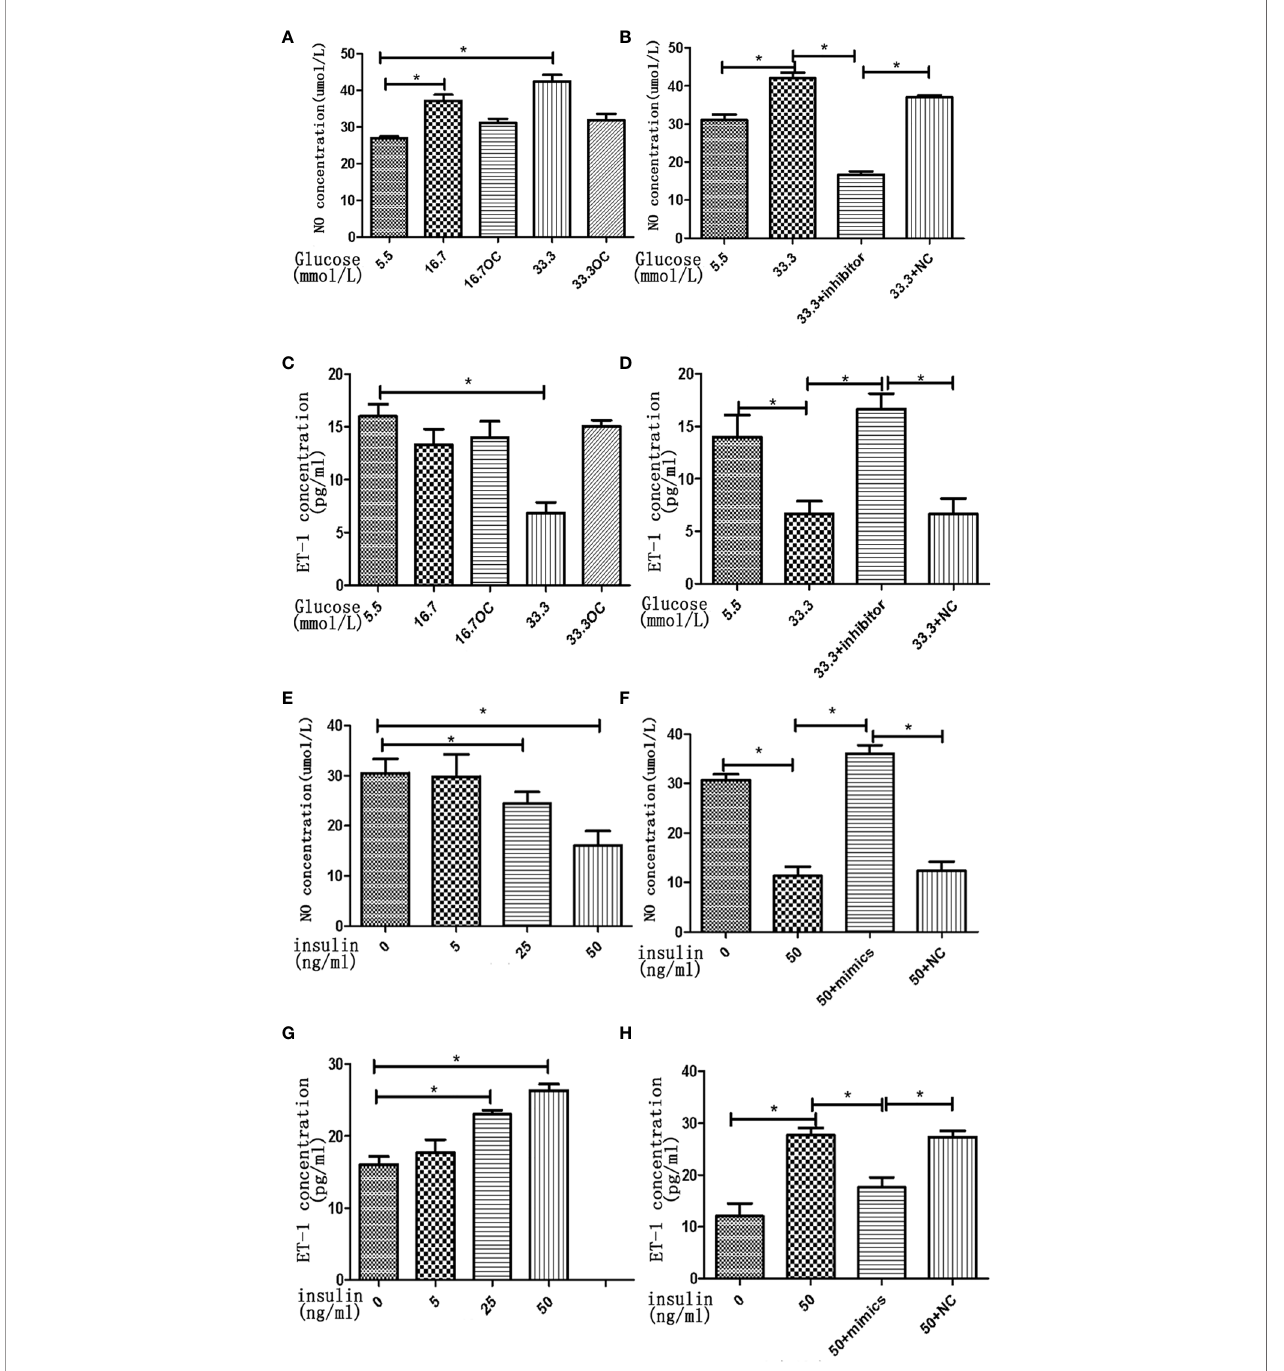
FIGURE 6 | High concentrations of glucose and insulin regulate NO and ET-1 secretion in HGECs. (A) : NO seretion of HGECs treated with different concentrations of glucose and 0ng/ml concentration of insulin for 48h. (B) : NO seretion of HGECs transfected with miR-21 inhibitor or inhibitor NC and treated with different concentrations of glucose and 0ng/ml concentration of insulin for 48h. (C) : ET-1 secretion of HGECs in groups in (A). (D) : ET-1 secretion of HGECs in groups in (B). (E) NO seretion of HGECs treated with different concentrations of insulin and 8.3mmol/L concentration of glucose for 48h. (F) : NO seretion of HGECs transfected with miR-21 mimics or mimics NC and treated with different concentrations of insulin and 8.3mmol/L concentration of glucose for 48h. (G) : ET-1 secretion of HGECs in groups in (E). (H) ET-1 secretion of HGECs in groups in (F) . Data are reported as mean ± SD, *P < 0.05. All data are representative of three independent experiments. OC,osmotic control; NC, normal control; NO, nitric oxide; ET-1, endothelin-1; inhibitor, miR-21 inhibitor; mimics, miR-21